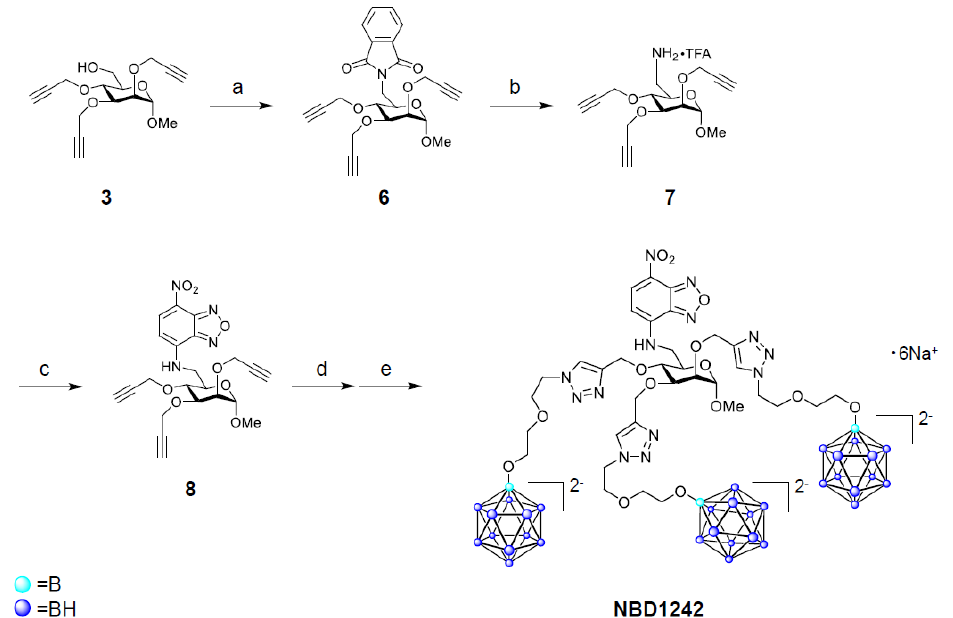
Figure 2. Synthesis of NBD1242. Reaction conditions and yields: ( a ) phthalimide, triphenylphosphine, diethyl azodicarboxylate (40% in toluene), tetrahydrofuran, 5 °C to rt; ( b ) hydrazine monohydrate, ethanol, rt, then preparative RP-HPLC (containing 0.05% trifluoroacetic acid), (50%); ( c ) 4-fluoro-7- nitro-2,1,3-benzoxadiazole, triethylamine, N , N -dimethylformamide, 50 °C (38%); ( d ) 5 , copper (II) sulfate pentahydrate, sodium L -ascorbate, tert -butanol/H 2 O (1/2, v / v ), 70 °C; ( e ) H 2 O, Amberlite ® IR120B Na (19%, 2 steps).